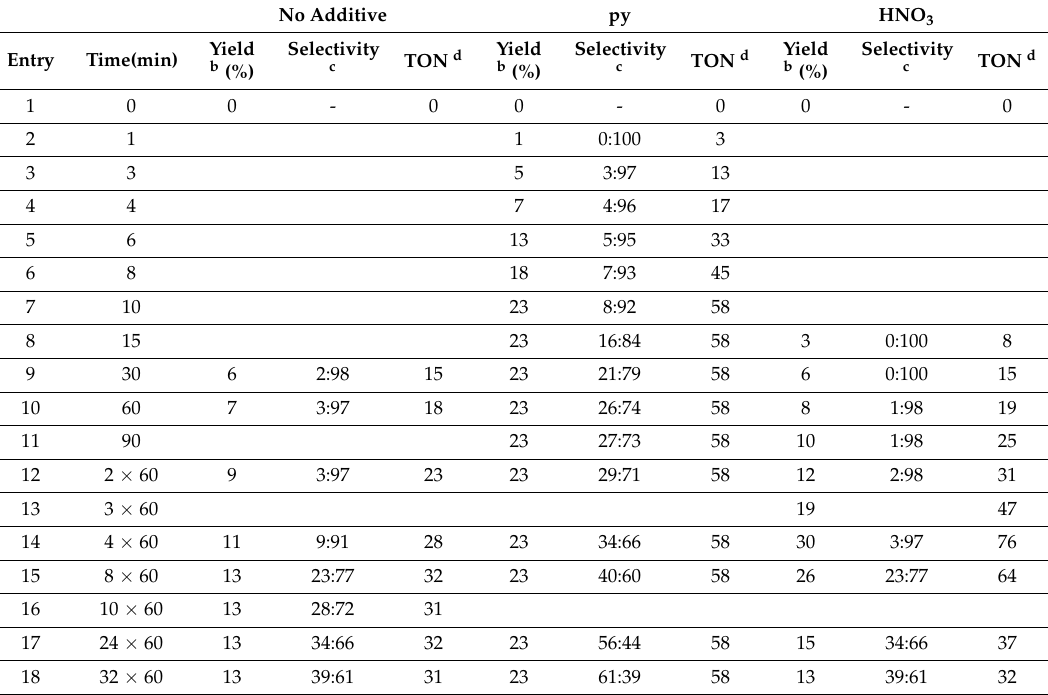
Table 3. Effect of the presence of an additive in the oxidation of cyclooctane catalyzed by 5 a .